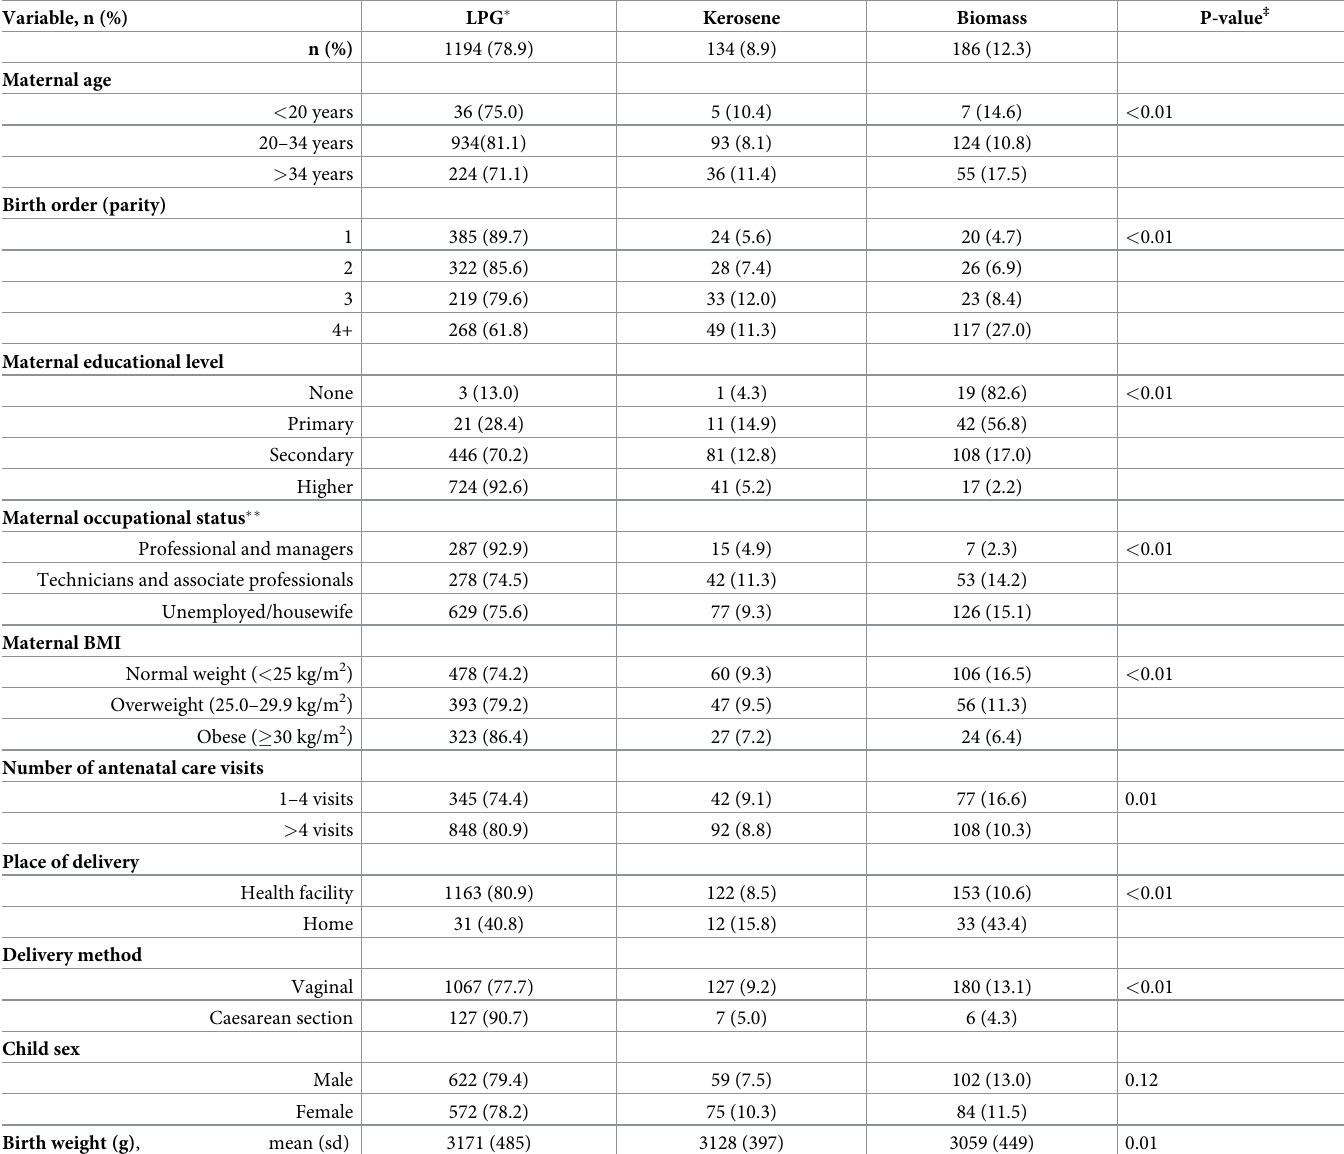
Table 1. Maternal and infant characteristics by cooking fuel type among term births, CEGROMS (N = 1514). Variable, n